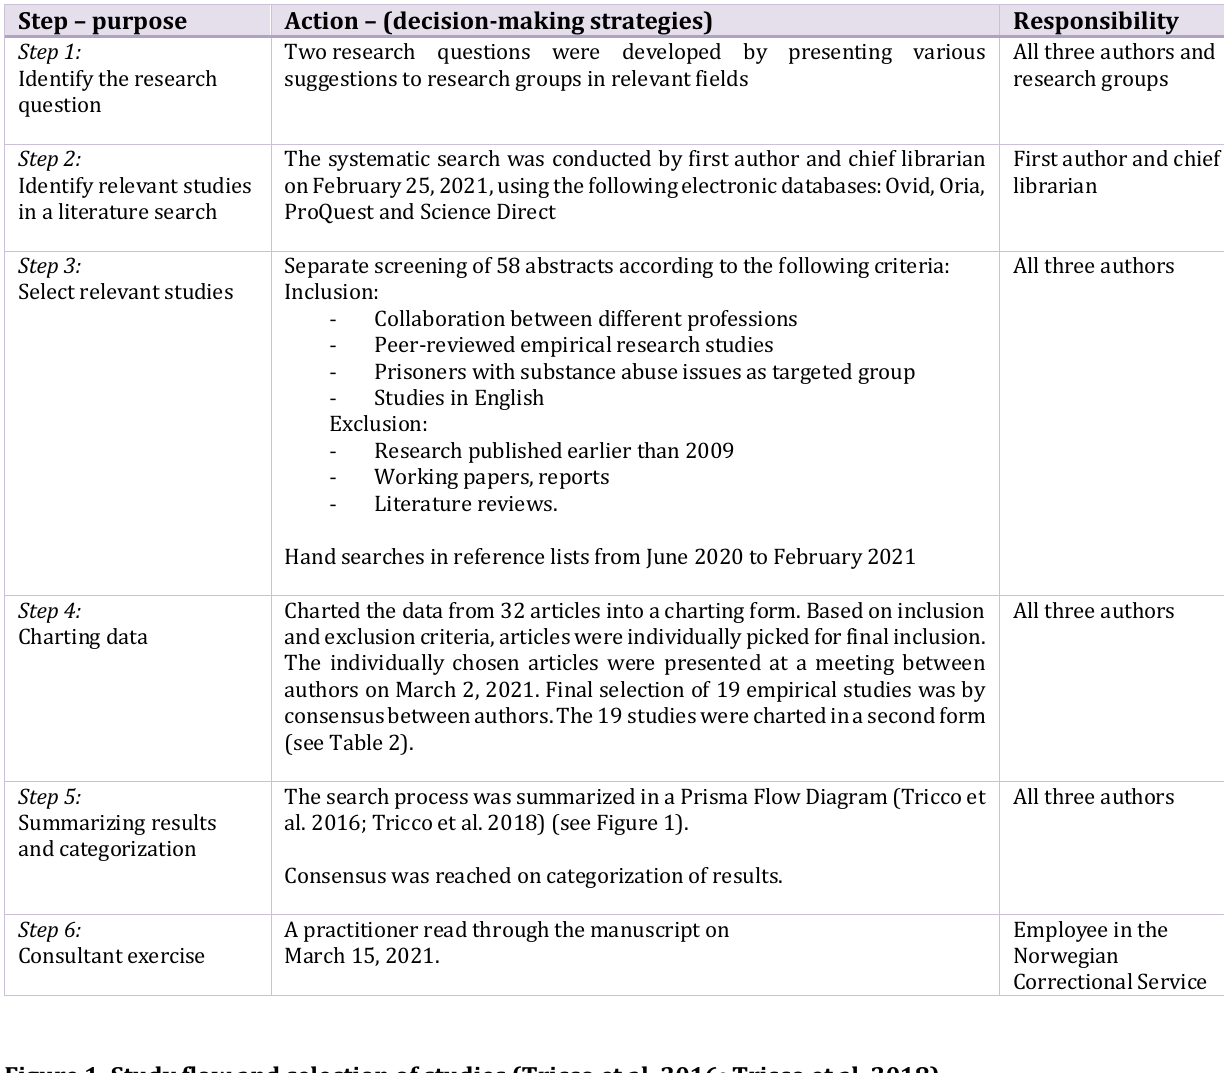
Figure 1. Study flow and selection of studies (Tricco et al. 2016; Tricco et al.